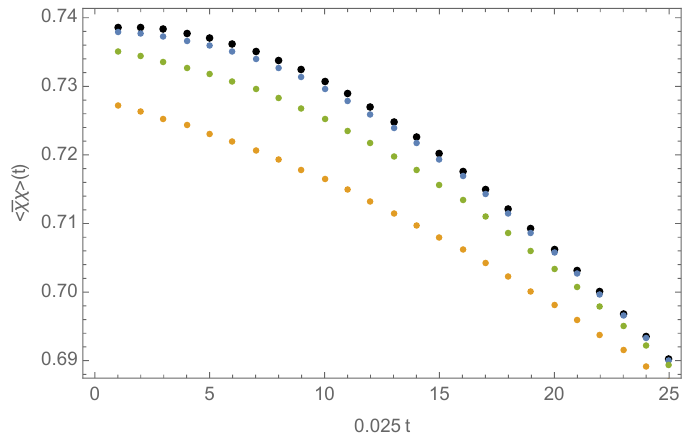
Figure 11 . Comparison of the instantaneous quench answer (black dots) in eq. (4.25) with the time-dependent solution for J(cid:14)t = 0 : 5 (orange dots), J(cid:14)t = 0 : 25 (green dots) and J(cid:14)t = 0 : 1 (blue